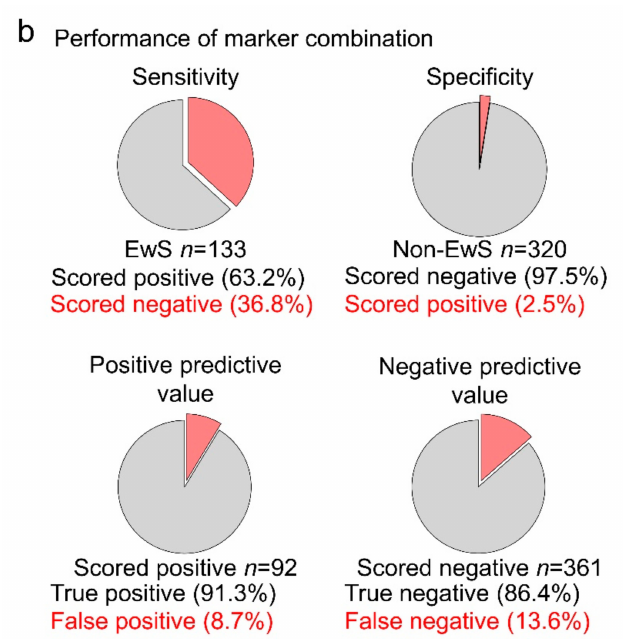
Figure 4. Proposed work-flow for immunohistochemical diagnosis of EwS. ( a ) Scheme of the proposed work-flow for immunohistochemical diagnosis of EwS; ( b ) pie charts indicating the performance of the proposed diagnostic procedure in the cohort of 133 EwS and 320 samples of 11 di ff erential